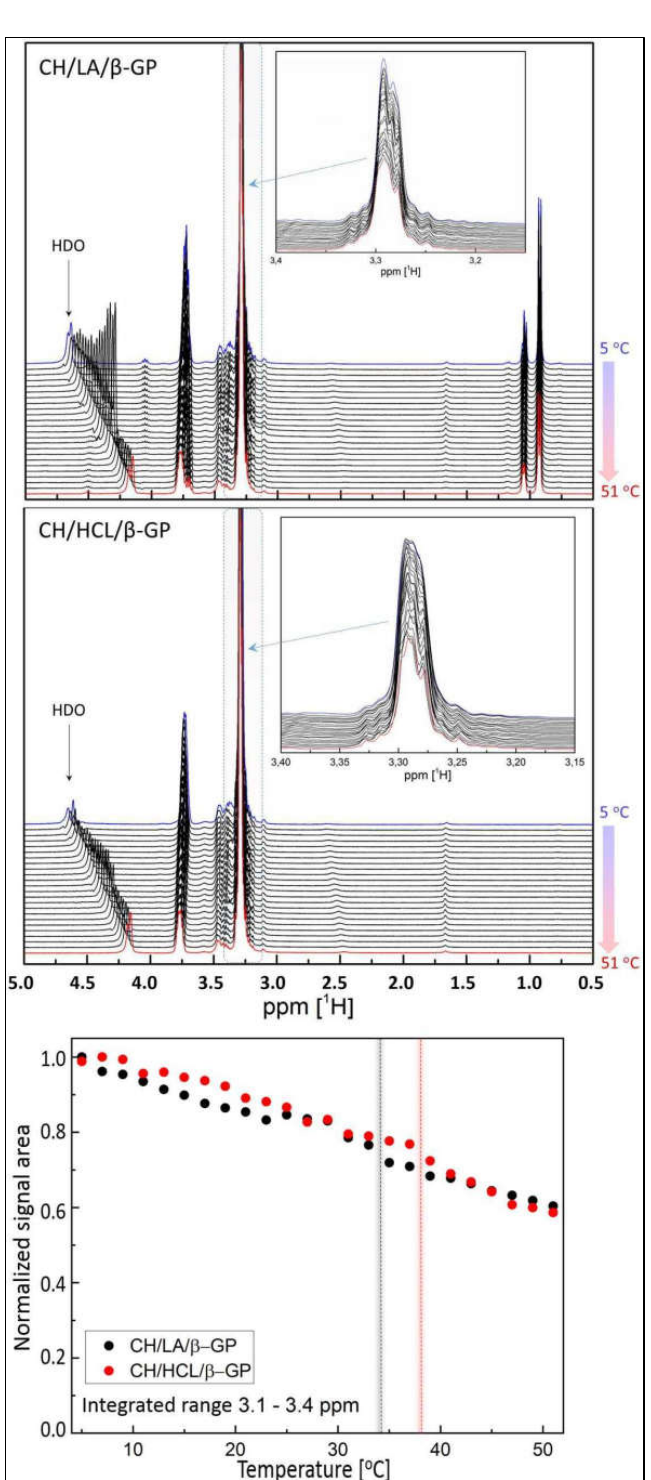
Figure 7. ( top, middle ) The 1 H NMR spectra recorded for the CH/LA/β-GP and CH/HCL/β-GP sys- Figure 7. ( top , middle ) The 1 H NMR spectra recorded for the CH/LA/ β -GP and CH/HCL/ β -GP tems in the temperature range of 5–51 °C; ( bottom ) The NMR signal intensity vs. temperature. systems in the temperature range of 5–51 ◦ C; ( bottom ) The NMR signal intensity vs. temperature. Interestingly, these subtle transitions observed in the NMR spectra evolution corrob- orate the well-presented rheological data above. Both the storage and the loss of moduli data (Figure 1), together with the damping factor data (Figure 2), indicate that there